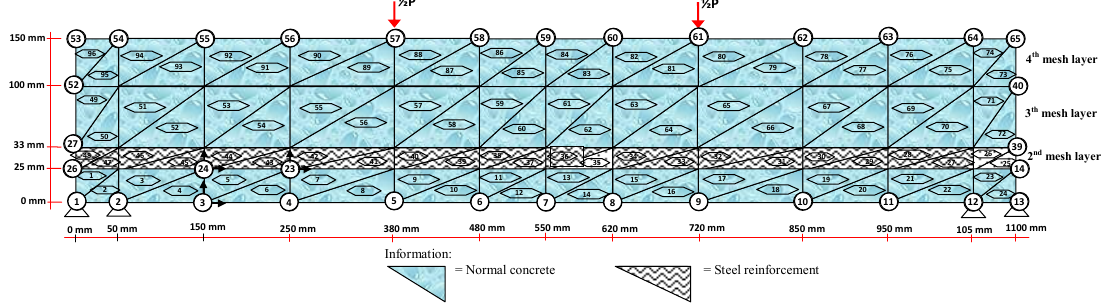
Figure 4. Discretization of the triangular element on the steel-reinforced concrete (SRC) beam. The modulus of elasticity ( E ) for each layer is calculated according to the condition of the material. Layers of concrete and bamboo reinforcement are calculated using the following Equation (2)